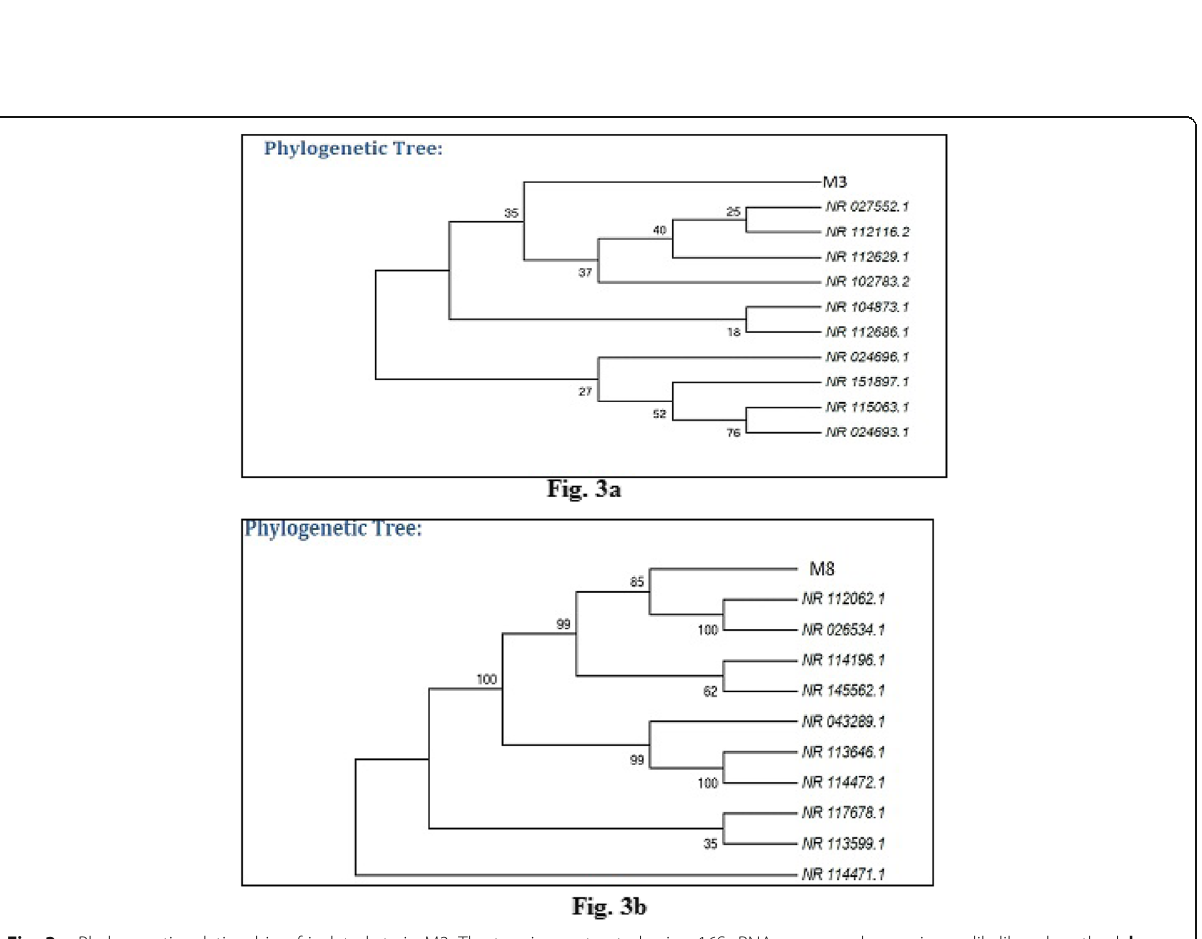
Fig. 3 a Phylogenetic relationship of isolated strain M3. The tree is constructed using 16S rRNA sequence by maximum likelihood method. b Phylogenetic relationship of isolated strain M8. The tree is constructed using 16S rRNA sequence by maximum likelihood